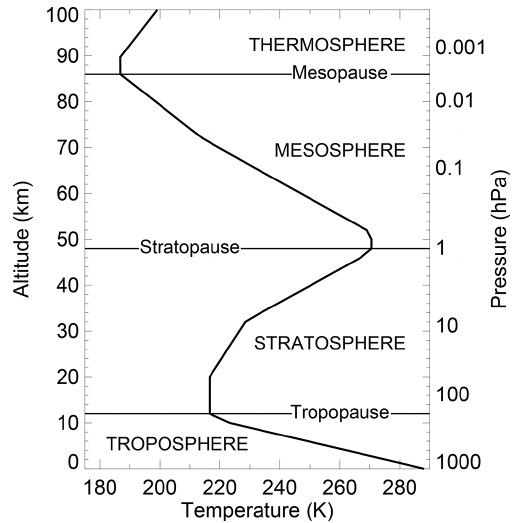
Figure 1. Annually averaged mid-latitude temperature profile, based on the US Standard Atmosphere (Committee on Extension of Standard Atmosphere, 1976; Minzner,